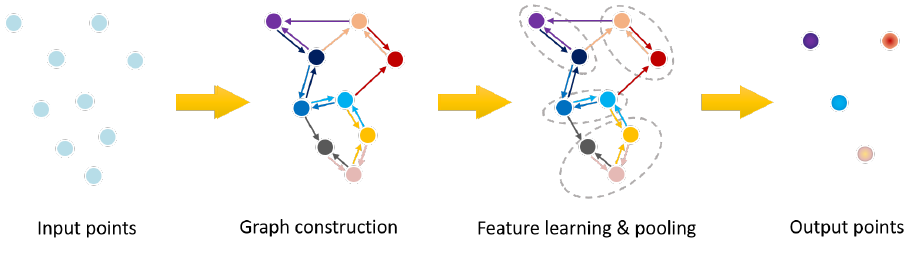
Figure 12. Graph-based networks principle